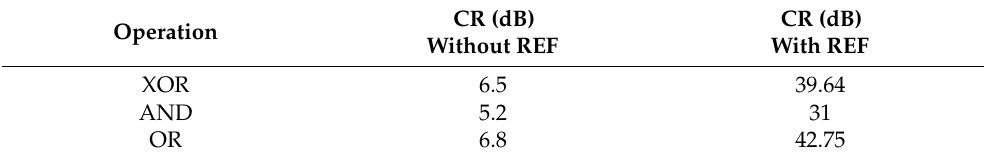
Table 4. CR without and with REF.